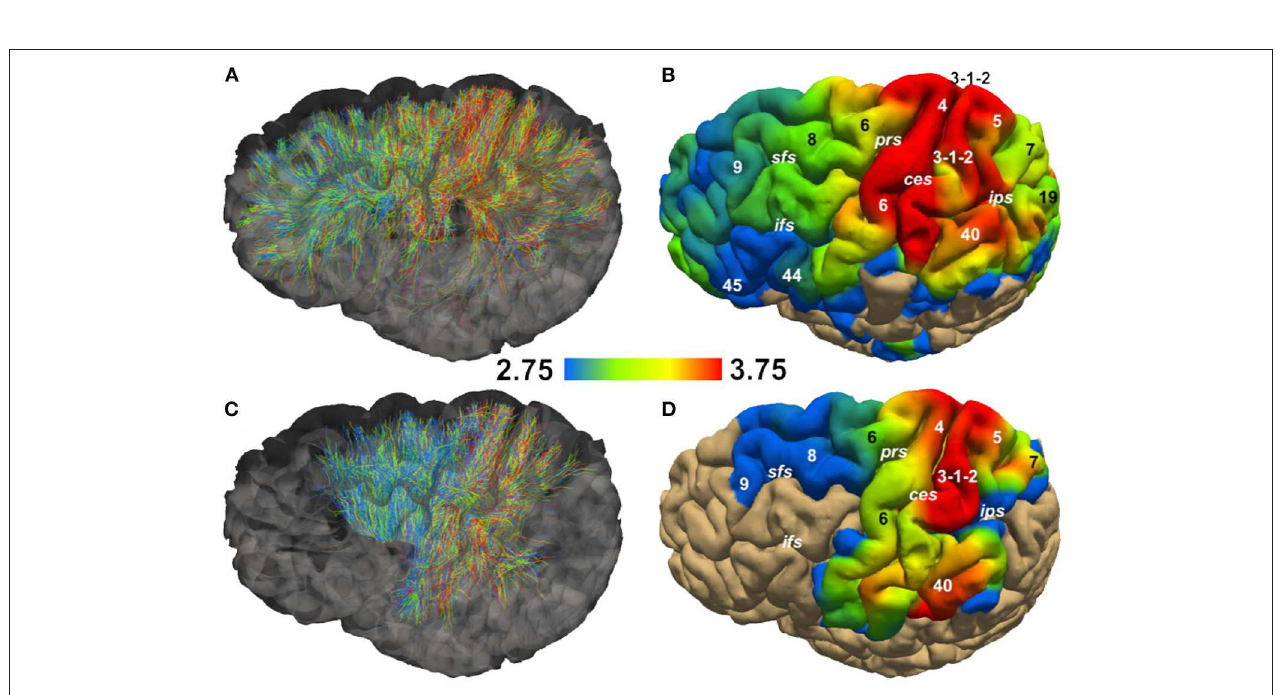
FIGURE 5 | Streamline Axon Diameter Index (sADI) in the Corpus Callosum (CC) and posterior limb of the internal capsule (PIC) of a single healthy volunteer. (A,C) show streamlines colored according to their sADI. (B,D) show the projection of streamlines’sADI onto the pial surface; colors correspond to the sADI averaged across streamlines. Abbreviations: ces, central sulcus; ifs, inferior frontal sulcus; ips, interparietal sulcus; prs, precentral sulcus; sfs, superior frontal sulcus. Numbers correspond to Brodman areas.